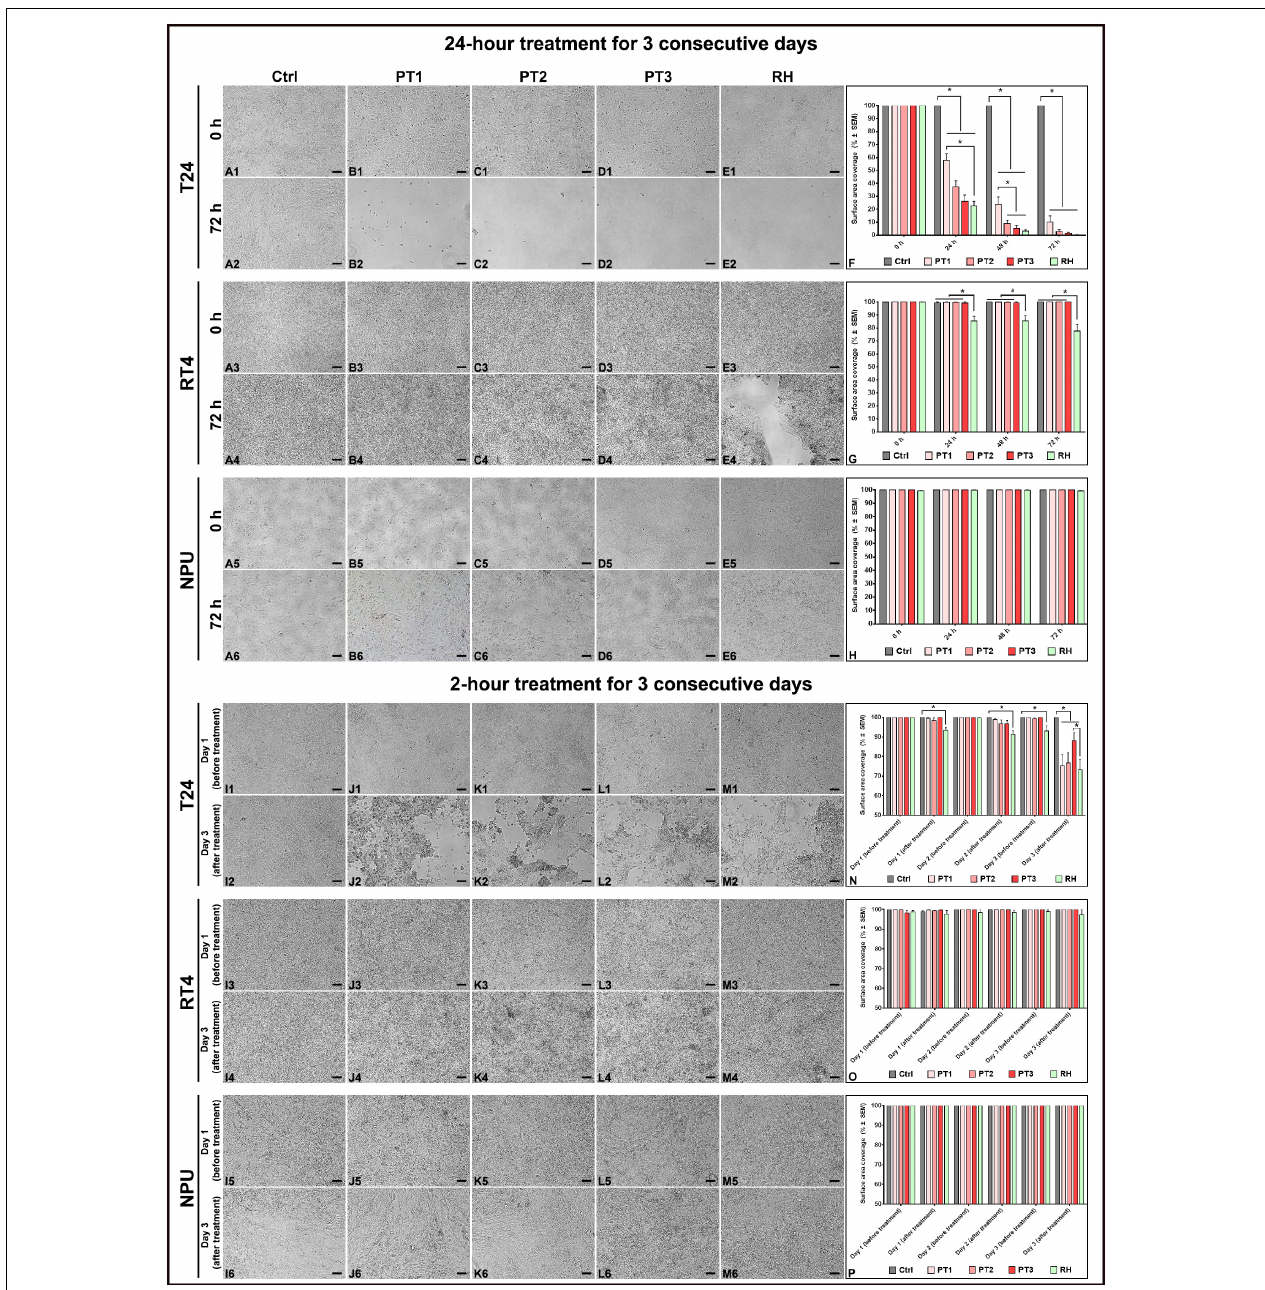
FIGURE 3 | Different hAM homogenate preparations cause detachment of cancer urothelial cells in a time-dependent manner. (A1–A6) Confluent cultures of T24, RT4, and NPU cells incubated with an appropriate culture medium without hAM homogenate remained attached to the culture surface after the 72-h treatment period. (B1–E2) 72-h treatment with different hAM homogenate preparations resulted in a significant detachment of T24 cells. (B3–E4) Only hAM homogenate prepared with Russell Hobbs caused detachment of RT4 cells after the 72-h treatment period. (B5–E6) Different hAM homogenate preparations did not cause any detachment of NPU cells after the 72-h treatment period. (I1–I6) Confluent cultures of T24, RT4, and NPU cells incubated with an appropriate culture medium without hAM homogenate remained attached to the culture surface on the third day of the 2-h treatment period. (J1–M2) Different hAM homogenate preparations caused detachment of T24 cells on the third day of the 2-h treatment period. (J3–M4) Confluent cultures of RT4 cells incubated with different hAM homogenate preparations remained attached to the culture surface on the third day of the 2-h treatment period. (J5–M6) Different hAM homogenate preparations did not induce detachment of NPU cells in three consecutive days of 2-h treatment. (F,N) The percentage of surface area covered with T24 cells after 24- and 2-h treatment for three consecutive days. (G,O) The percentage of surface area covered with RT4 cells after 24- and 2-h treatment for three consecutive days. (H,P) The percentage of surface area covered with NPU cells after 24- and 2-h treatment for three consecutive days. The quantified data here are presented as mean surface area coverage ± SEM. Data were obtained from three independent experiments, each performed with a different biological sample of hAM. Within each experiment, three technical replicates were performed. Scale bars: 100 µ m. * p <